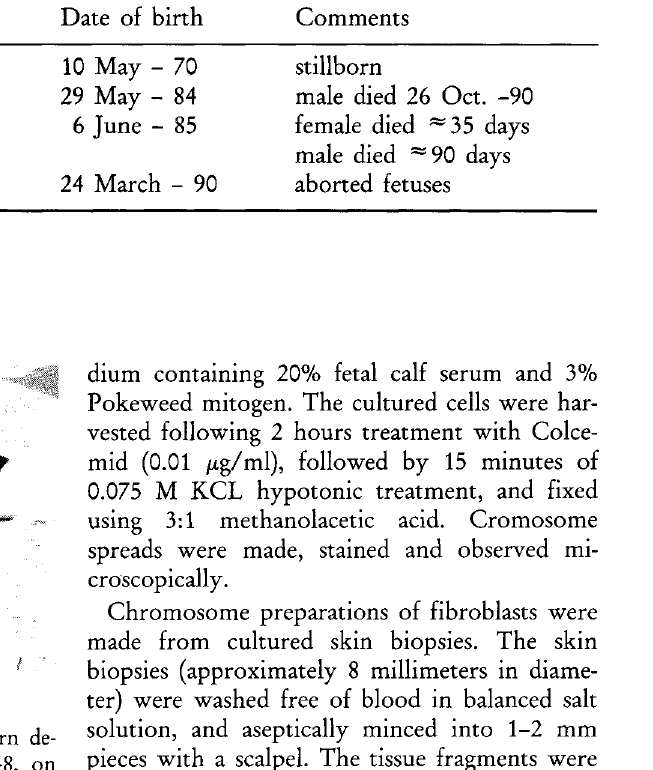
Fig. 1. The differences in physical size and horn de velopment between the freemartin, #248, on the left and the normal cow, #234, on the right, is apparent (photographed at ages five and eleven respectively). The horn boss width of 32.5 cm is nearly identical to that of its male co-twin (32.0 cm) and double the width of its dam (16.0 cm).